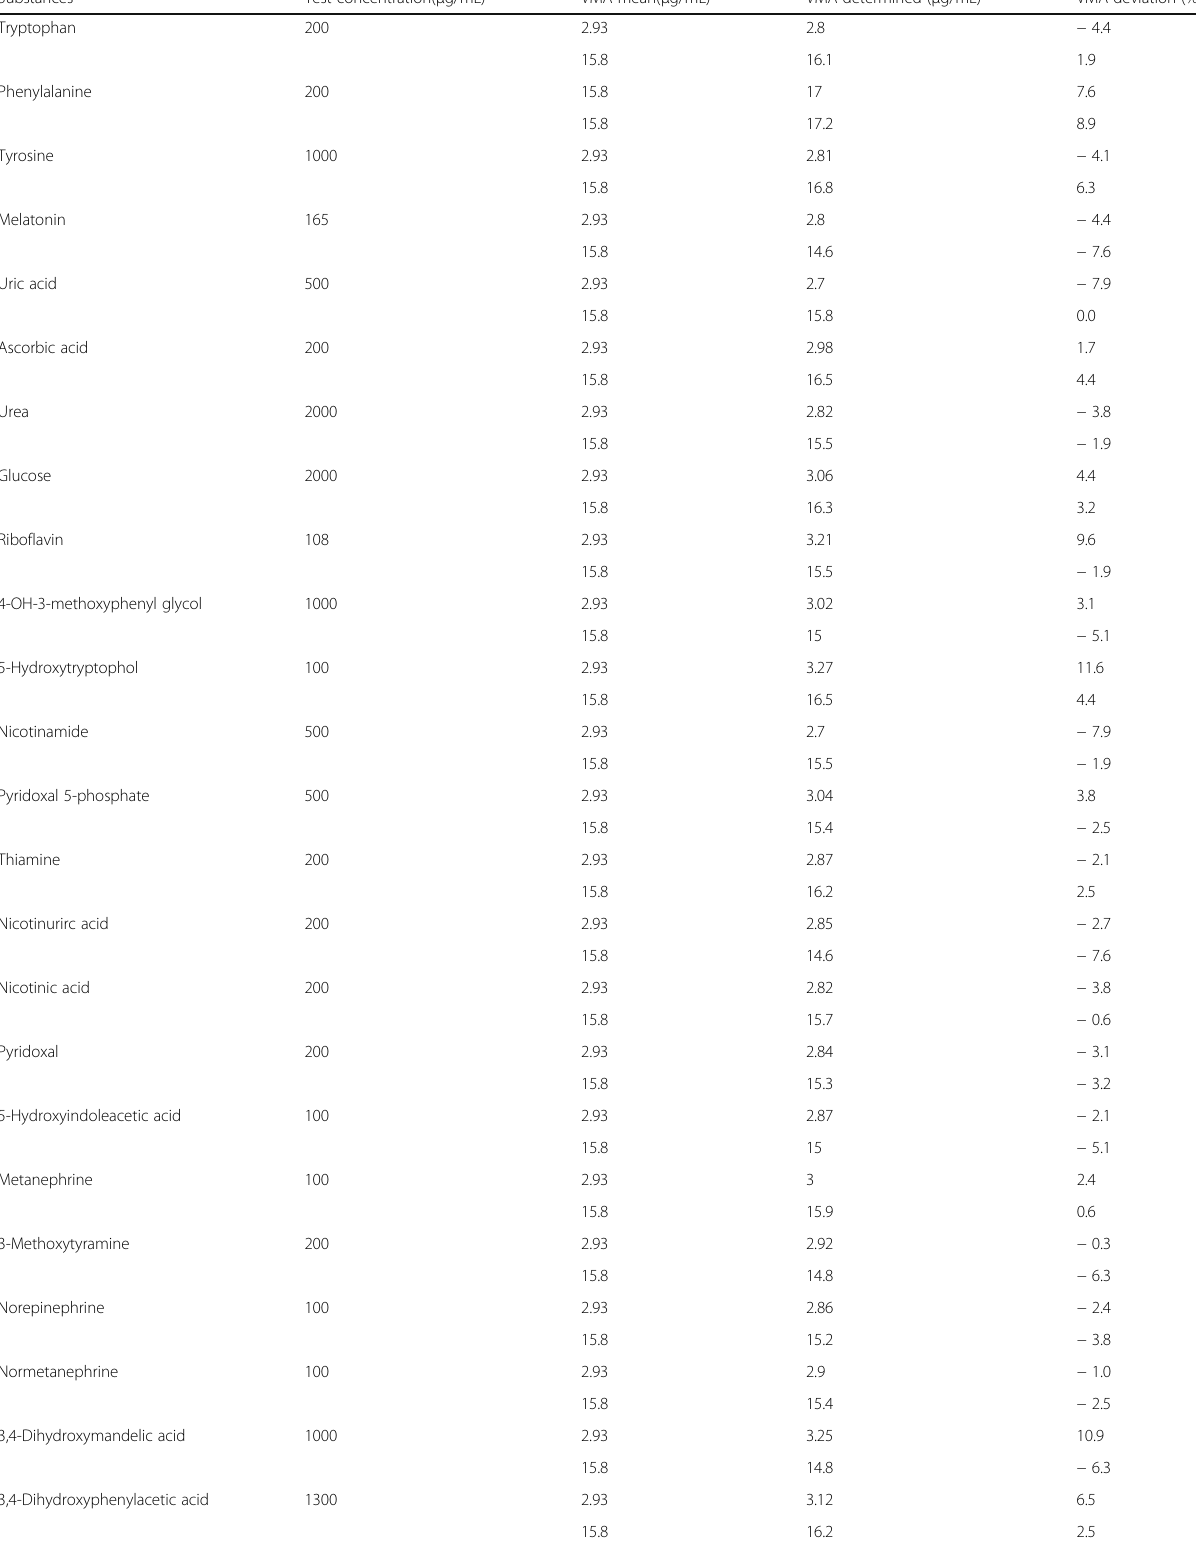
Table 3 Deviations from baseline concentrations of VMA for endogenous potential